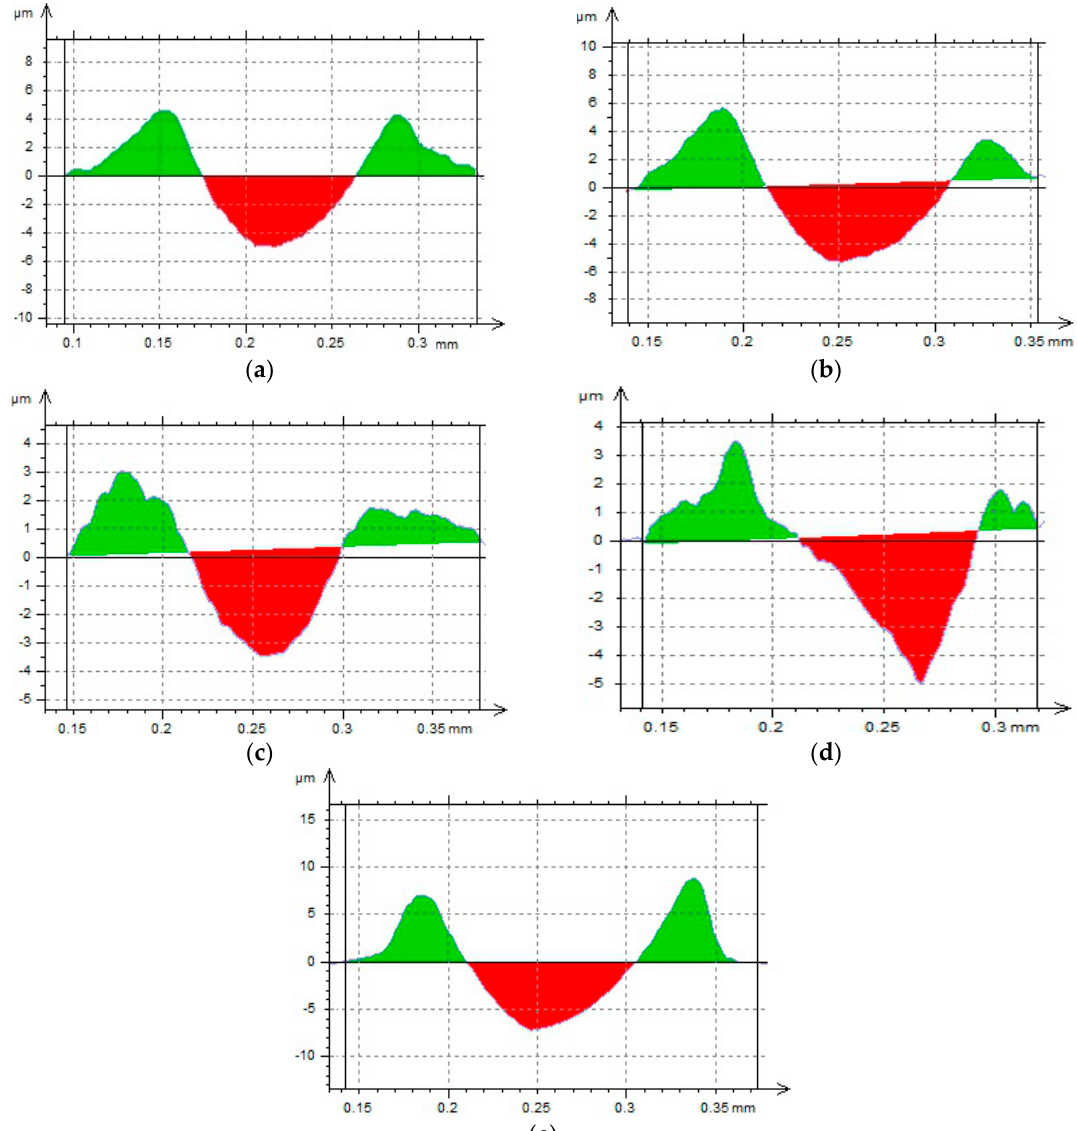
Figure 4. Transverse profiles of oxide coating and aluminum alloy surfaces after scratch test: ( a – d ): Sample designations in Table 2, ( e ): Aluminum alloy EN AW-5251.